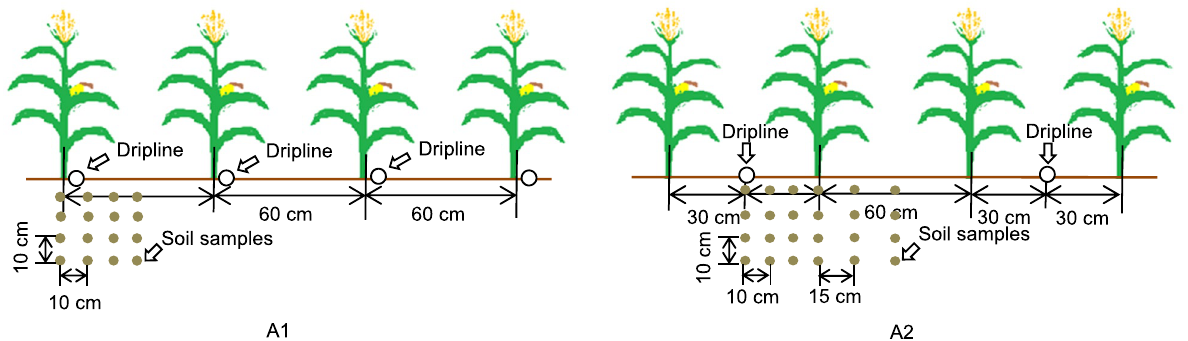
Figure 2. Schematic diagram of layout of one drip line per row of maize (A1), one drip line per two rows of maize (A2) and soil samples. Graphs were created using Microsoft Office version 2010. Microsoft Office is